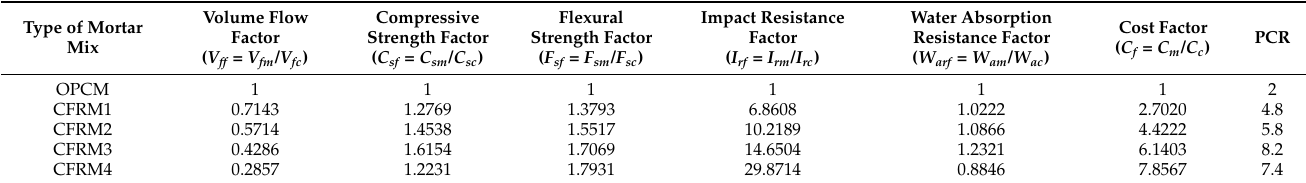
Table 5. PCRs of the different mortar